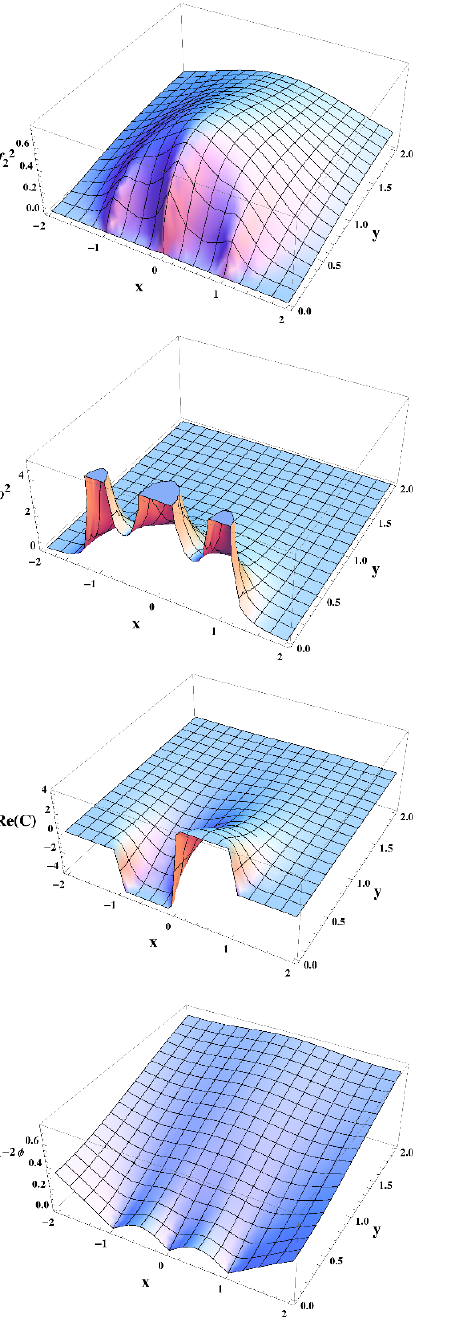
; f 2 and (cid:26) 2 , the real and imaginary parts 2 6